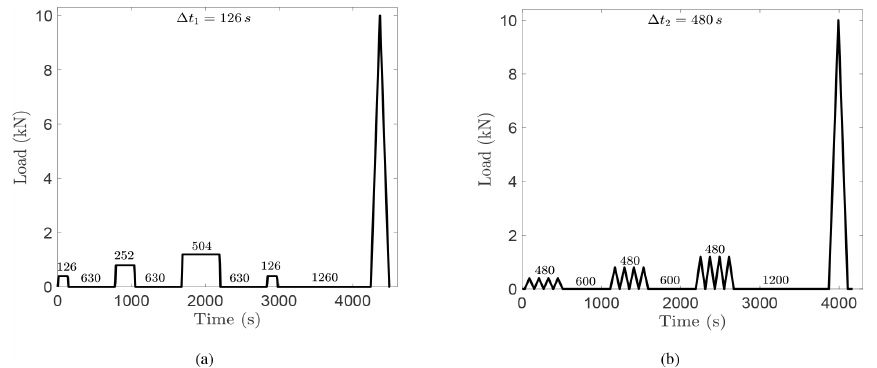
Figure 3. Loading consisting of (a) creep-recovery and (b) cyclic sequences followed by a monotonic fracture ramp. The number above each segment indicates the duration in